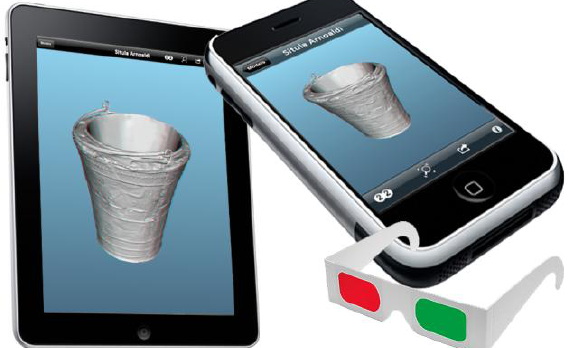
Figure 10. Stereo visualization of situla Arnoaldi on mobile